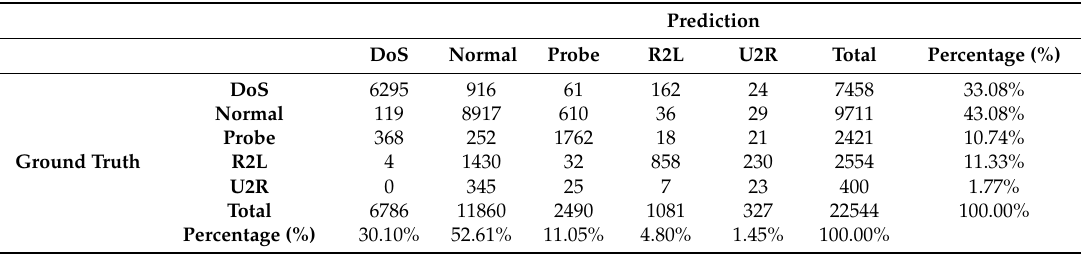
Table 1. Classification confusion matrix.